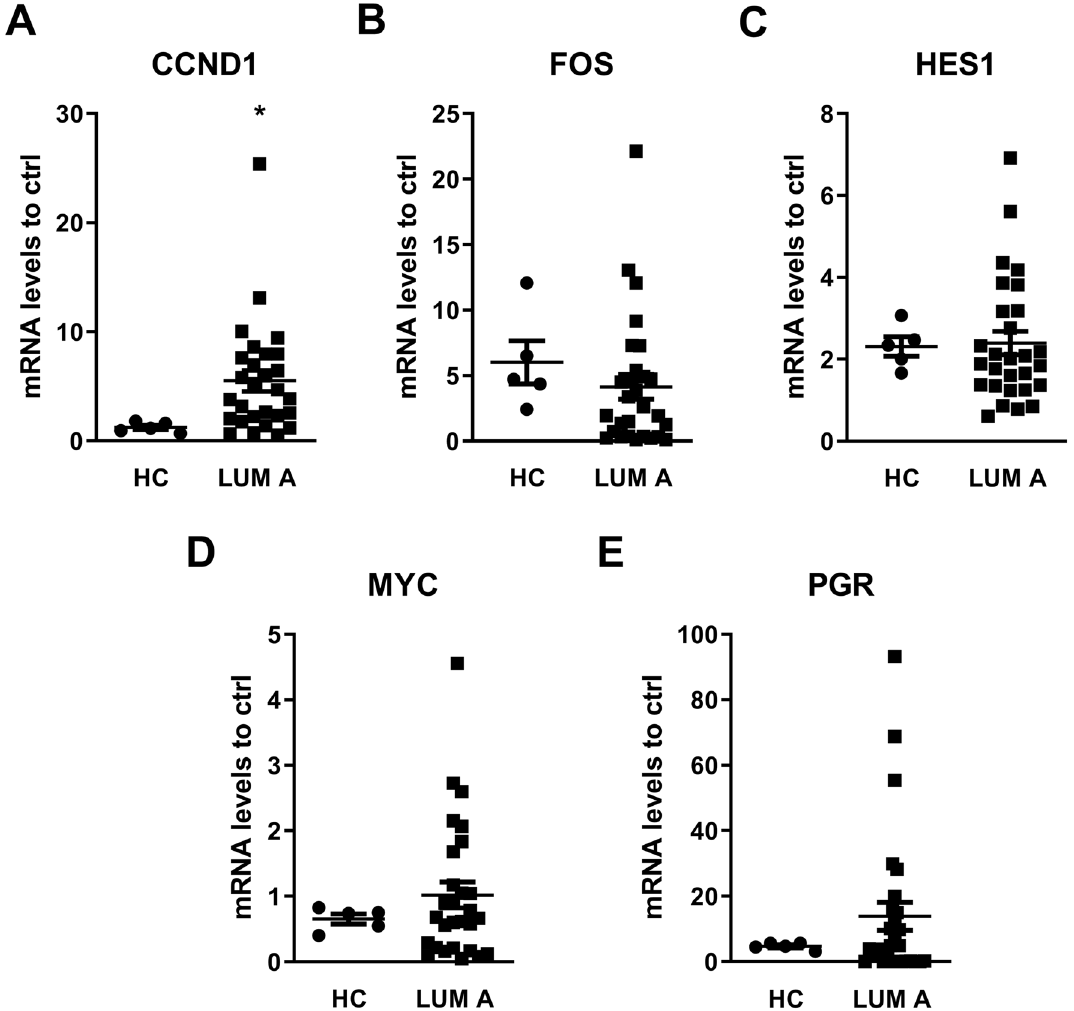
Figure 6. RT-qPCR of NRIP1 target genes. To determine the changes in the mRNA levels of the NRIP1 target genes in luminal A patients in comparison with healthy donors, RT-qPCR assays were performed. The endogenous gene GAPDH was used for data normalization. The mRNA levels of CCND1 ( A ) , FOS ( B ), HES1 ( C ) , MYC ( D ) and PGR ( E ) are differentially expressed in luminal A patients. The bars indicate the mean mRNA levels (± standard deviation). *p <